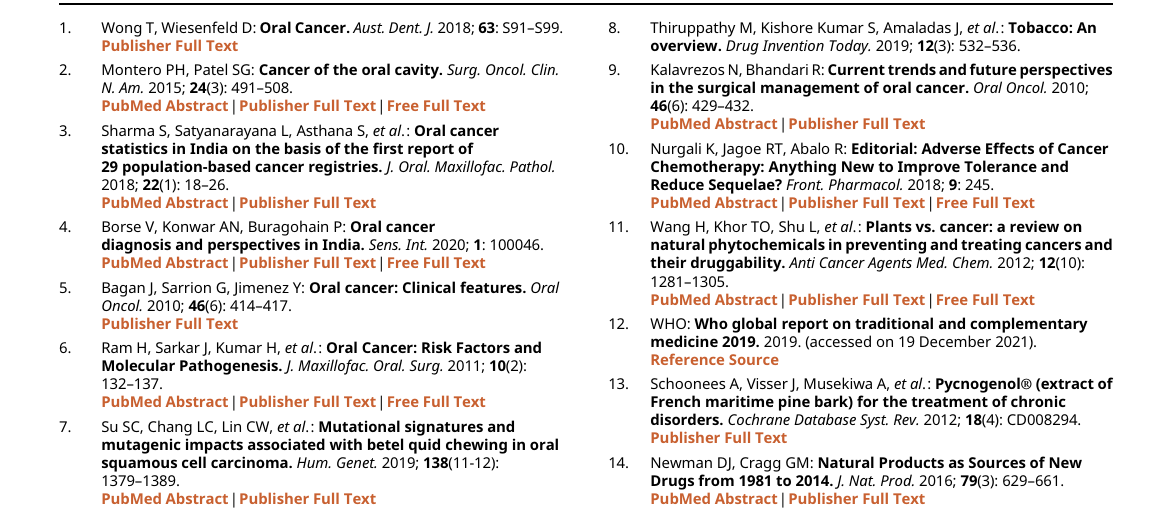
Figshare: [Raw data for effect of goji berry on CAL-27 cell lines (oral squamous cell carcinoma cell line].